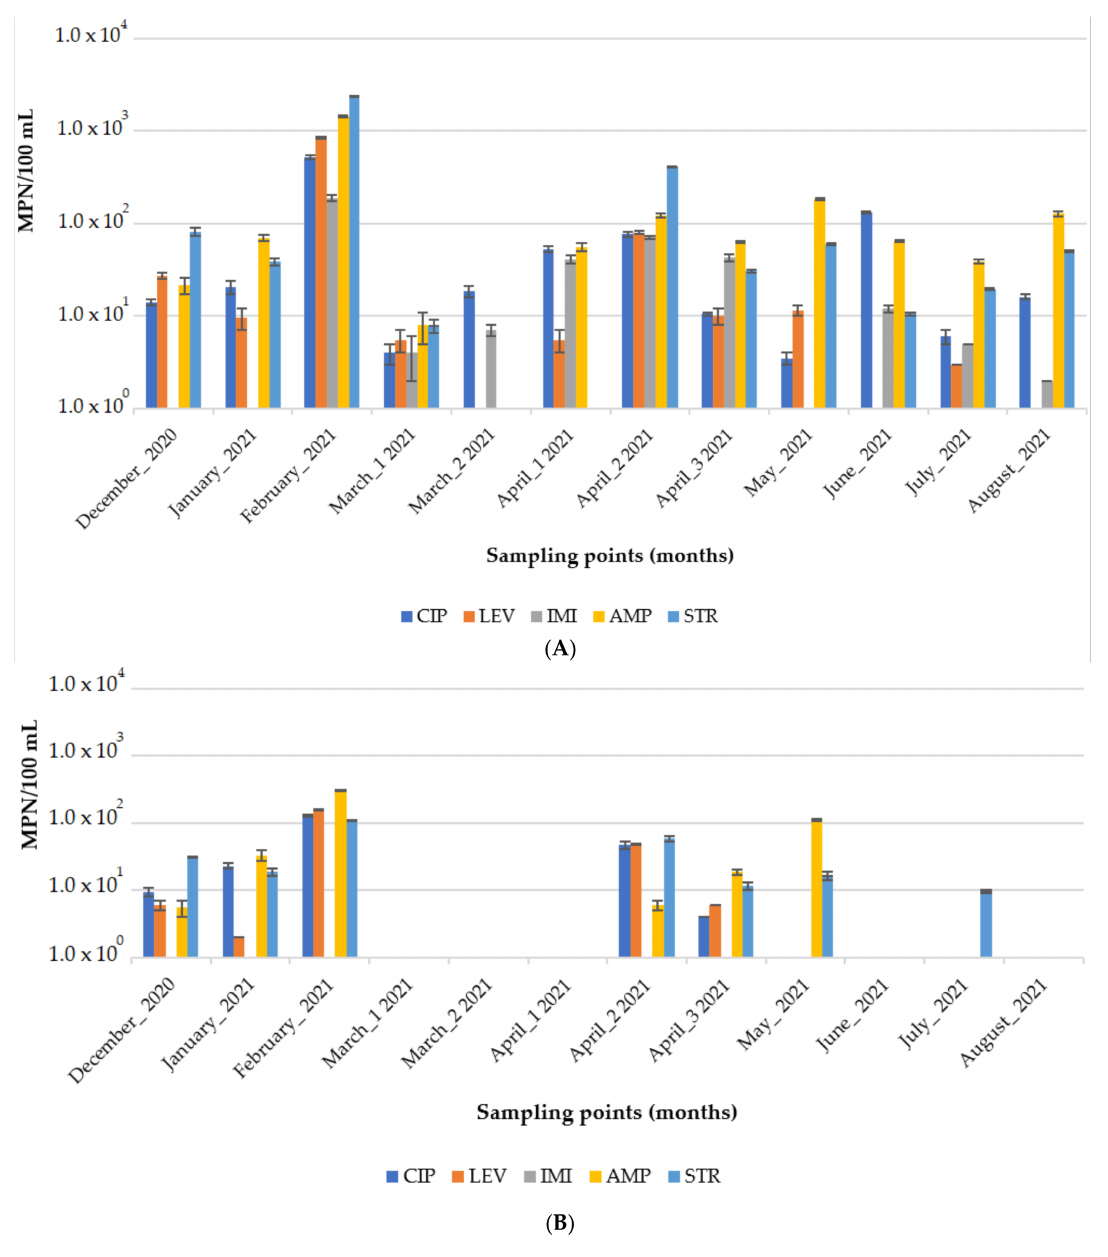
Figure A2. Occurrence levels (MPN/100 mL) of total coliforms ( A ) and Escherichia coli ( B ) resistant to ciprofloxacin (CIP), levofloxacin (LEV), imipenem (IMI), ampicillin (AMP), and streptomycin (STR) present in the collected surface water